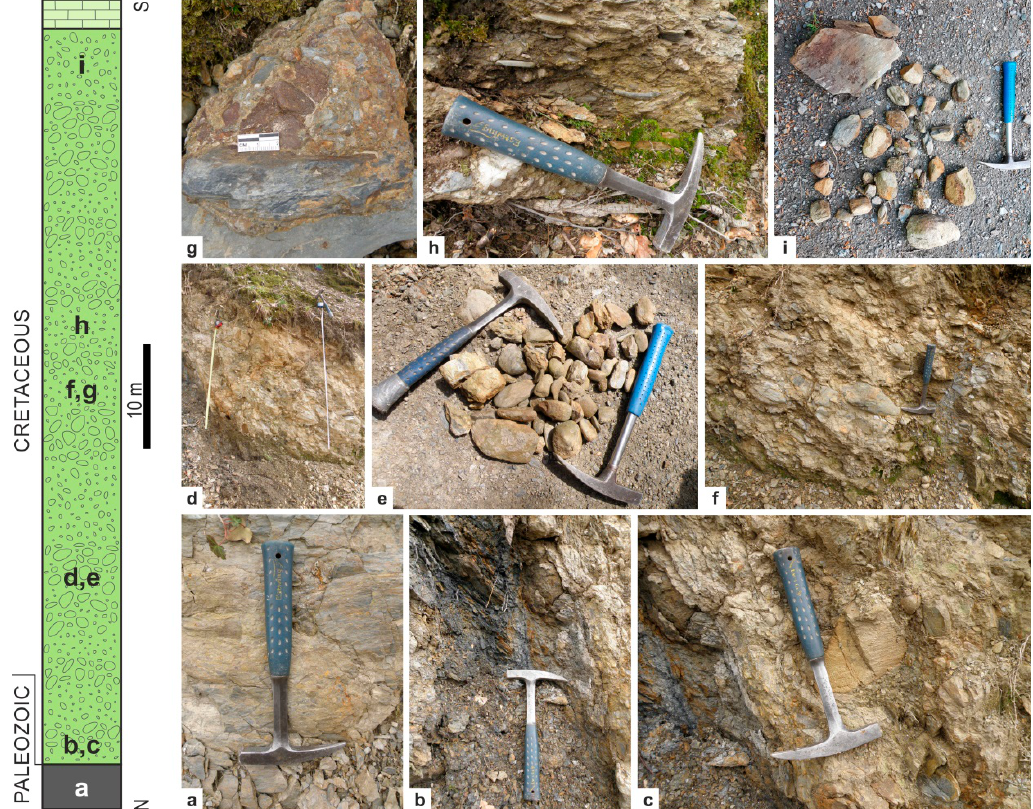
Figure 3. Field photographs from the studied section, with positions marked on a schematic column. ( a ) Weathered black slate in the base of the column; ( b ) boundary between the bedrock and conglomerate at Point 1; ( c ) enlarged detail of basal, poorly sorted conglomerate at Point 1; ( d ) area 1 × 1 m chosen for clast count at Statistics Point 2; ( e ) measured clasts at Statistics Point 2; ( f ) conglomerates at Point 5; ( g ) enlarged detail from the Point 5; ( h ) imbricated conglomerates with angular quartz fragment at Point 6; ( i ) measured clasts at Statistics Point 3, Position of Points shown on Figure 2. Hammer length 33 cm.